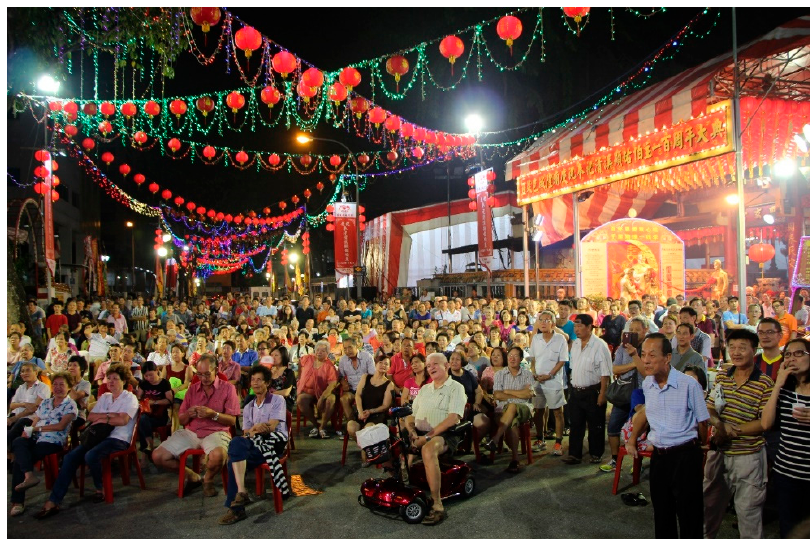
Figure 6. Audience members who did not have tickets to the getai performance had seats outside the temple to view the screen that was showing the live performance. (Image: Alvin Eng Hui Lim).